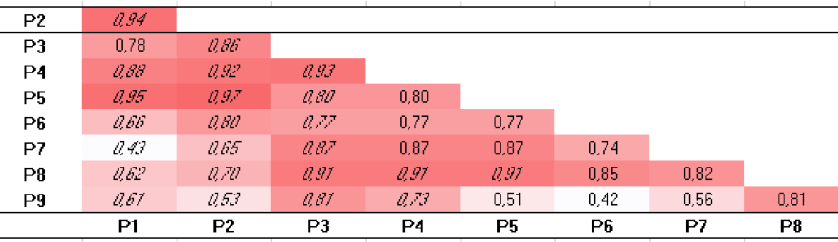
Table 2. Pearson’s correlation matrix applied to Cell II. Note: red marks positive relationships between profiles and blue marks negative relationships. Italic indicates p < 0 .